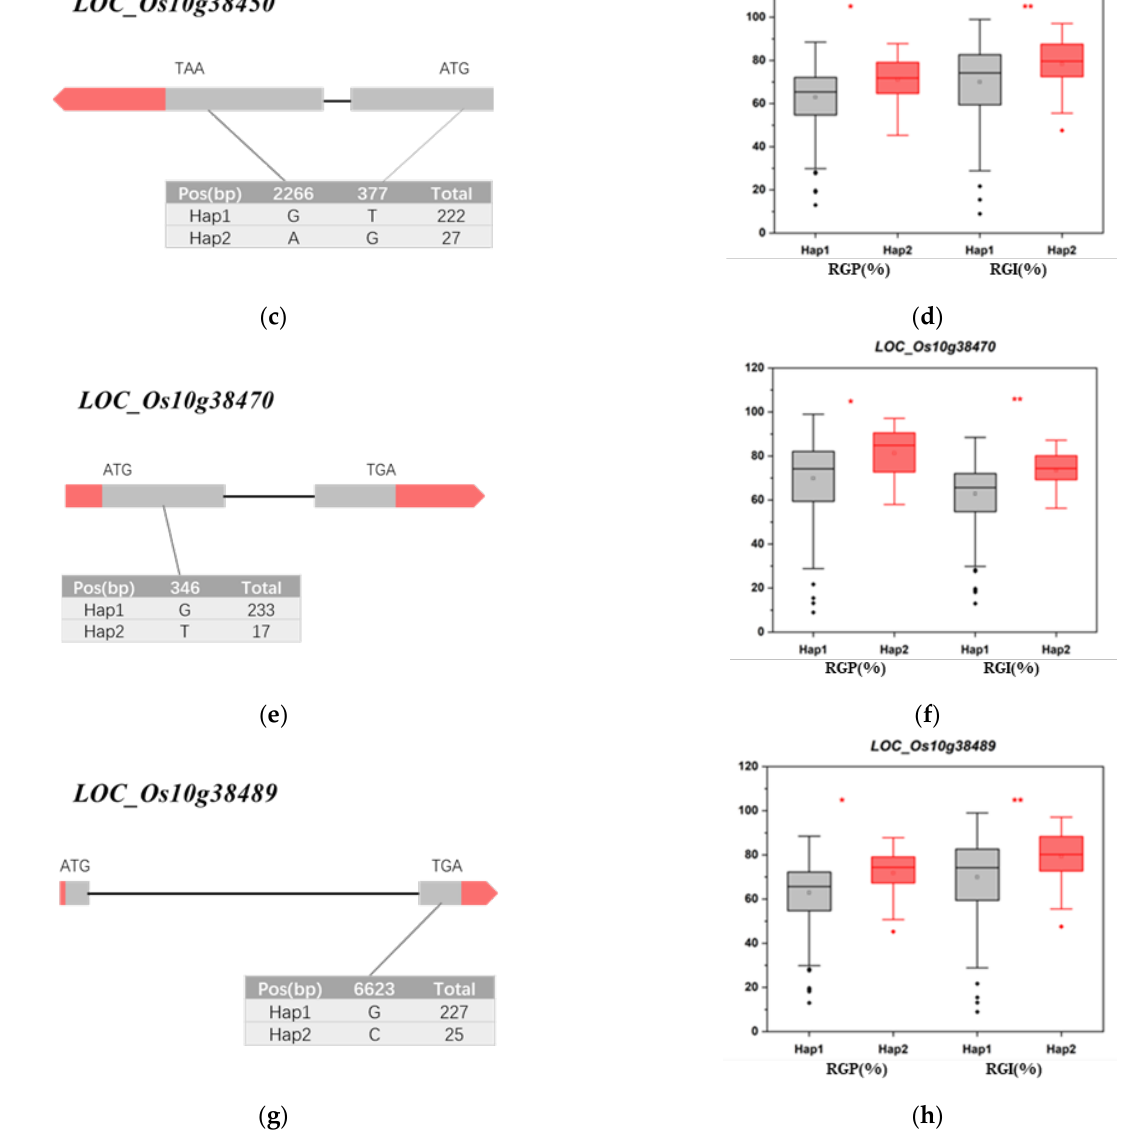
Figure 7. Gene structure and haplotype analysis. ( a , b ) represent the gene structure and haplotype analysis of LOC_Os10g38350 . ( c , d ) represent the gene structure and haplotype analysis of LOC_Os10g38450 . ( e , f ) represent the gene structure and haplotype analysis of LOC_Os10g38470 . ( g , h ) represent the gene structure and haplotype analysis of LOC_Os10g38489 . The * and ** suggest significance of ANOVA at p < 0.05 and p < 0.01, respectively.